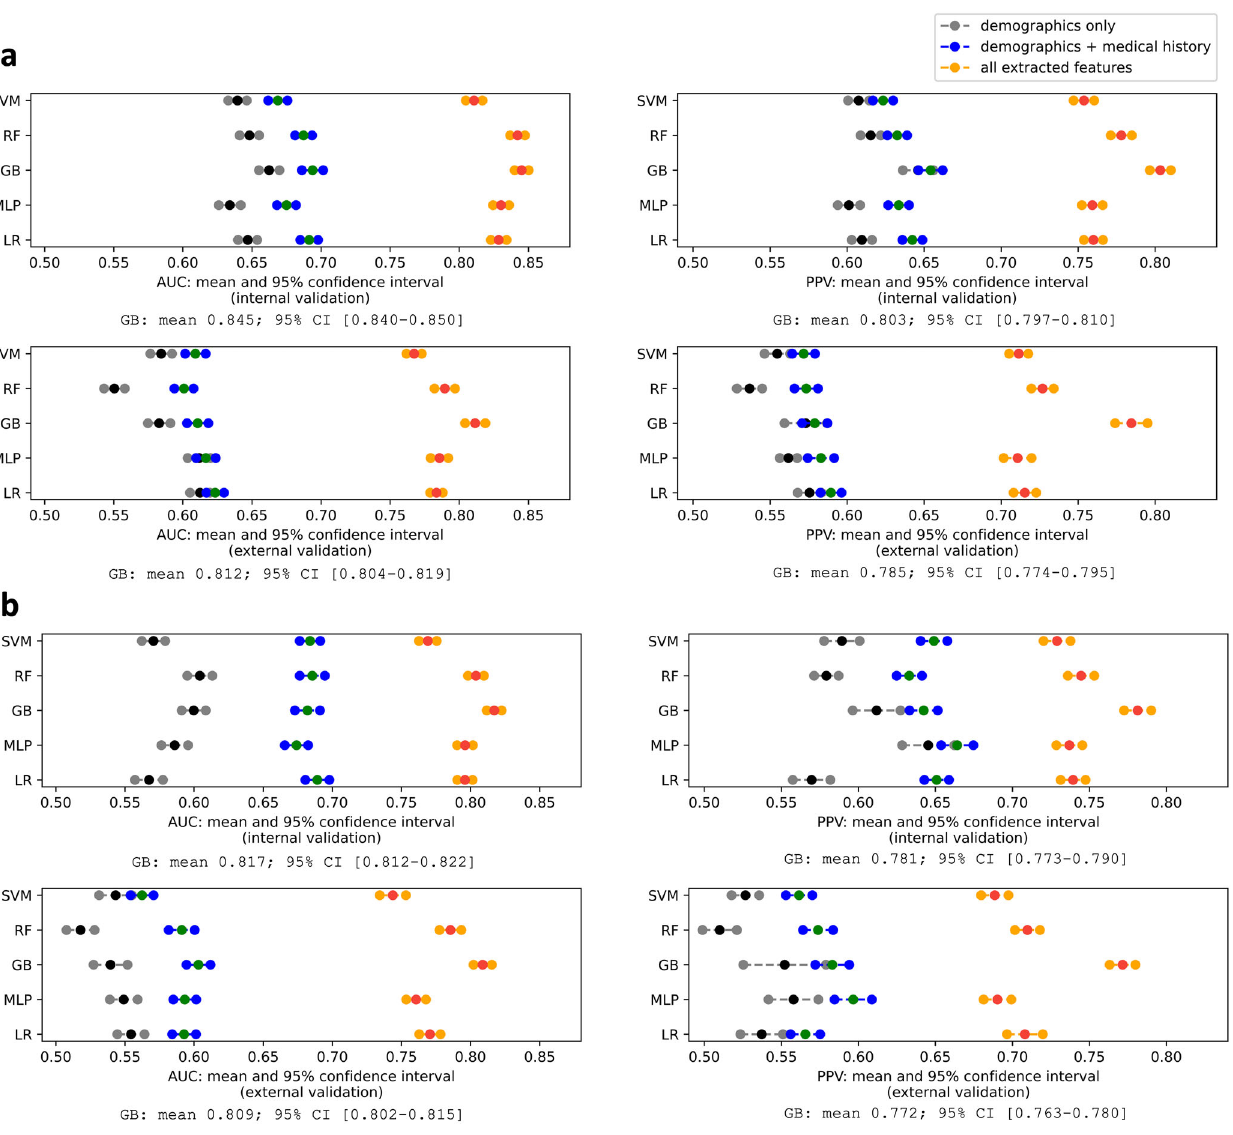
Fig. 3 Model performances in the binary recurrence classi fi cation using patient demographics, medical history, and tumor characteristics. a AUC and PPV in internal validation ( fi rst row) and external validation (second row) when experimenting on the original cohorts (MGB: 215 recurrences vs. 666 non-recurrences; DFCI: 95 recurrences vs. 340 non-recurrences). b AUC and PPV in internal validation ( fi rst row) and external validation (second row) when experimenting on the core complete cohorts: negative or not indicated regional lymph node histology, known mitotic rate, and known ulceration (MGB: 142 recurrences vs. 410 non-recurrences; DFCI: 74 recurrences vs. 317 non- recurrences). The best model performance among SVM, RF, GB, MLP, and LR models is speci fi ed below each